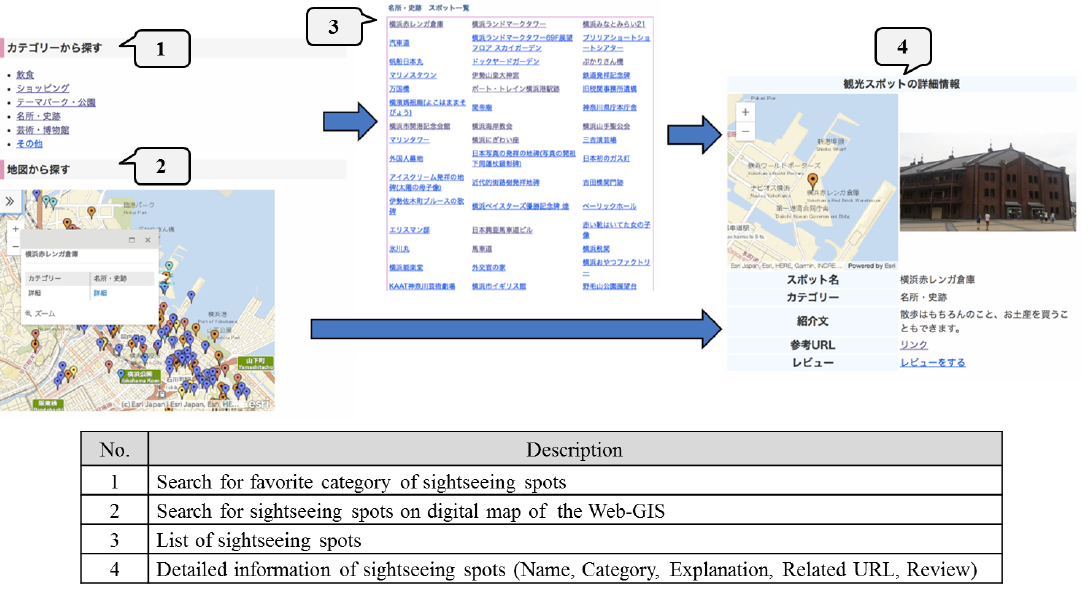
Figure 3. Pages for the viewing function of sightseeing spot information.